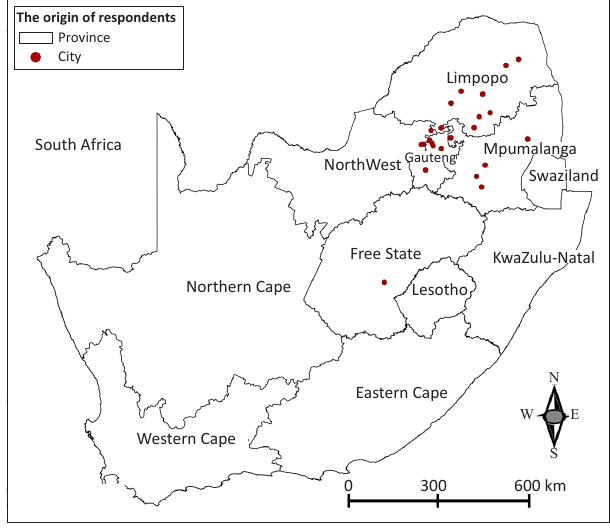
FIGURE 1: The origin of respondents who were